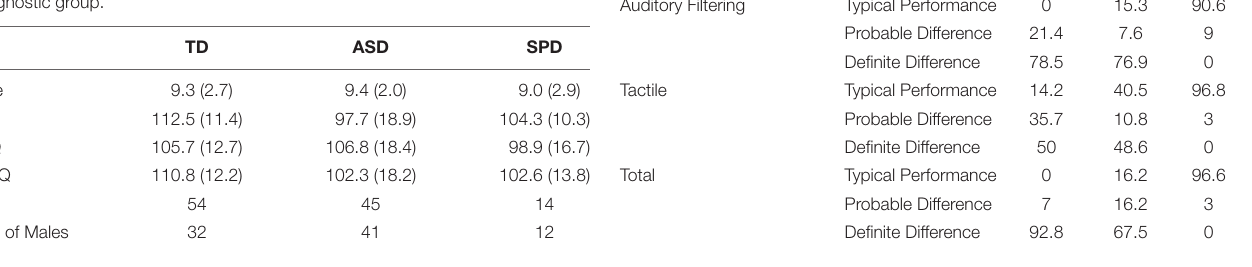
TABLE 1 | Means and standard deviations (in parentheses) for participant data, by diagnostic